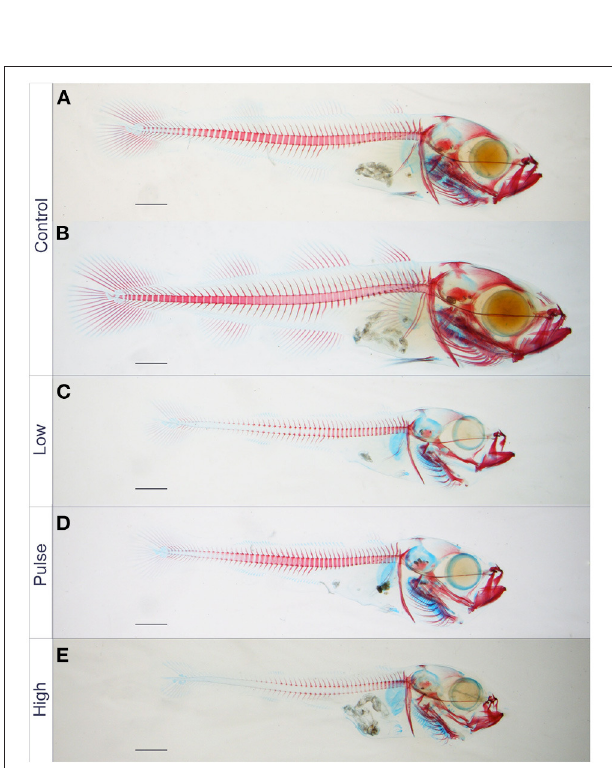
FIGURE 6 | Significantly reduced standard length of 44 dph juvenile Atlantic haddock exposed to crude oil, compared with the control (two control larvae shown). Standard length of haddock juveniles exposed to (C) low, (D) pulsating, and (E) high concentrations were significantly reduced compared with those in the control (A,B) . They also had more incomplete mineralization of the vertebral column compared with those in the control group. Scale bars: